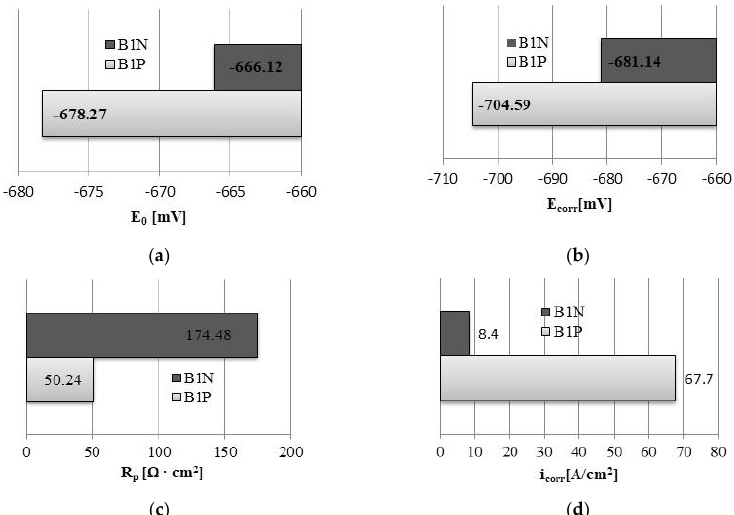
Figure 12. Results of the main parameters of electrochemical tests: ( a ) open circuit potential, ( b ) Figure12. Resultsofthemainparametersofelectrochemicaltests: ( a )opencircuitpotential, ( b )corrosion corrosion potential, ( c ) polarization resistance, ( d ) corrosion current density. potential, ( c ) polarization resistance, ( d ) corrosion current density. A higher corrosive resistance for samples with normalized conditions was also observed on the obtained polarization curves (Figure 13).